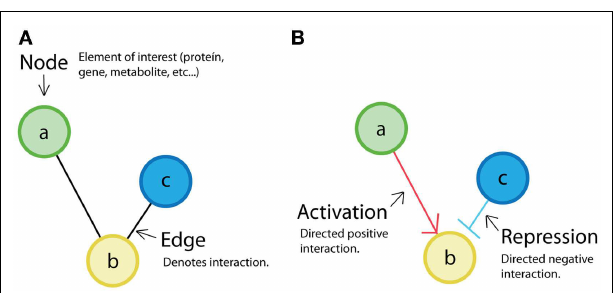
FIGURE 4 | Network representation: (A) classical representation of a non-directed network where nodes (a, b, c) are the elements of interest, and the edges represent interaction between elements . (B) Example of a directed network. In directed networks, the order (from source to destiny) is evident. Sometimes, positive relations (activations) are depicted by arrows, and negative ones (repression) are depicted by truncated lines. It is also possible to find directed networks in which all relations are represented by